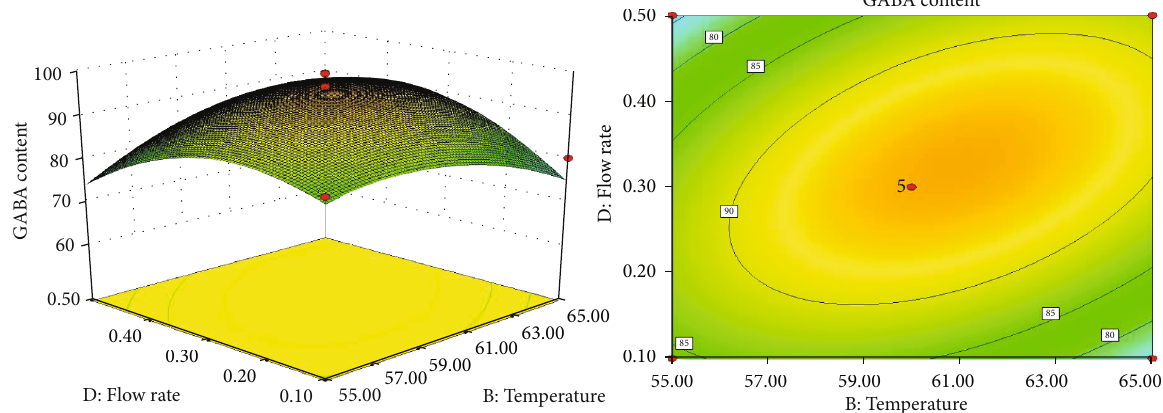
Figure 10: Response surface and contour diagram of temperature and fl ow rate in fl uence on GABA content.